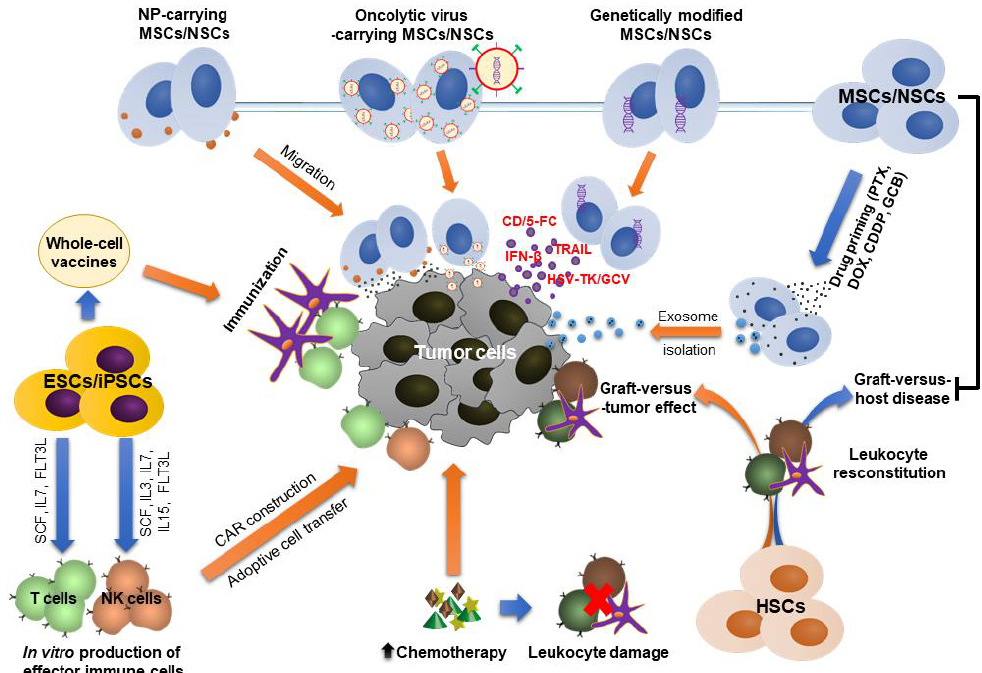
Figure 2. Strategies for the application of stem cell therapy in the treatment of cancer. (1) HSC transplantation has been used for the reconstitution of blood-forming cells and leukocytes after heavy chemotherapy or radiotherapy. (2) ESCs and iPSCs can be used for the production of effector immune cells that are then CAR constructed for adoptive cell transfer technology. In addition, ESCs and iPSCs can be potential sources for the production of anti-cancer vaccines. (3) MSCs/NSCs are effective to deliver genes, NPs, and OVs to tumor niche due to their intrinsic tumor tropism. In addition, exosomes extracted from the culture of drug-priming MSCs/NSCs can be used to target the drugs to tumor sites. Moreover, MSCs are capable of reducing GVHD in HSC transplantation.